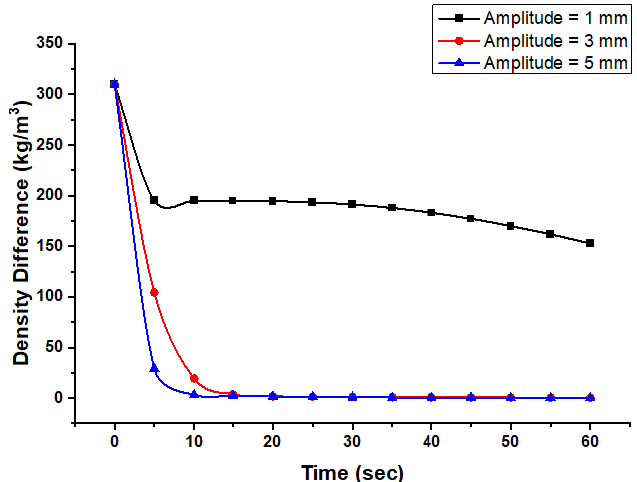
Figure 11. Mixing efficiency comparison based on amplitude.